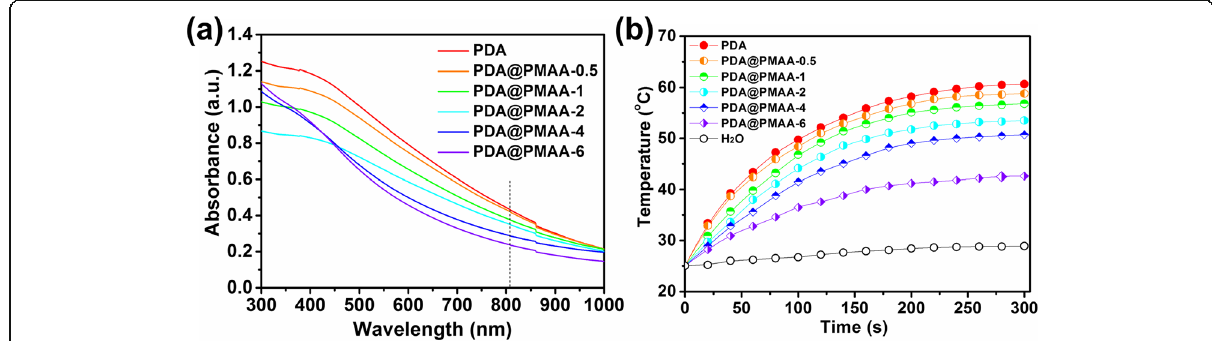
Fig. 5 a UV-vis spectra of PDA and PDA@PMAA aqueous dispersion at a concentration of 100 μ g mL − 1 . b Photothermal effect of PDA and